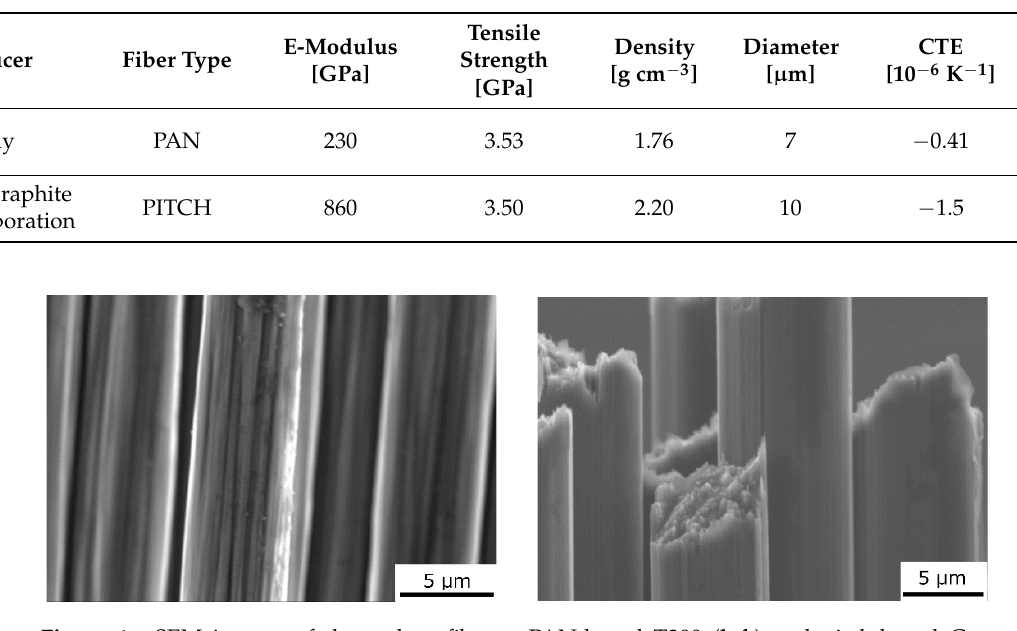
Table 1. Basic data for the T300 and Granoc carbon fibers [24,25].